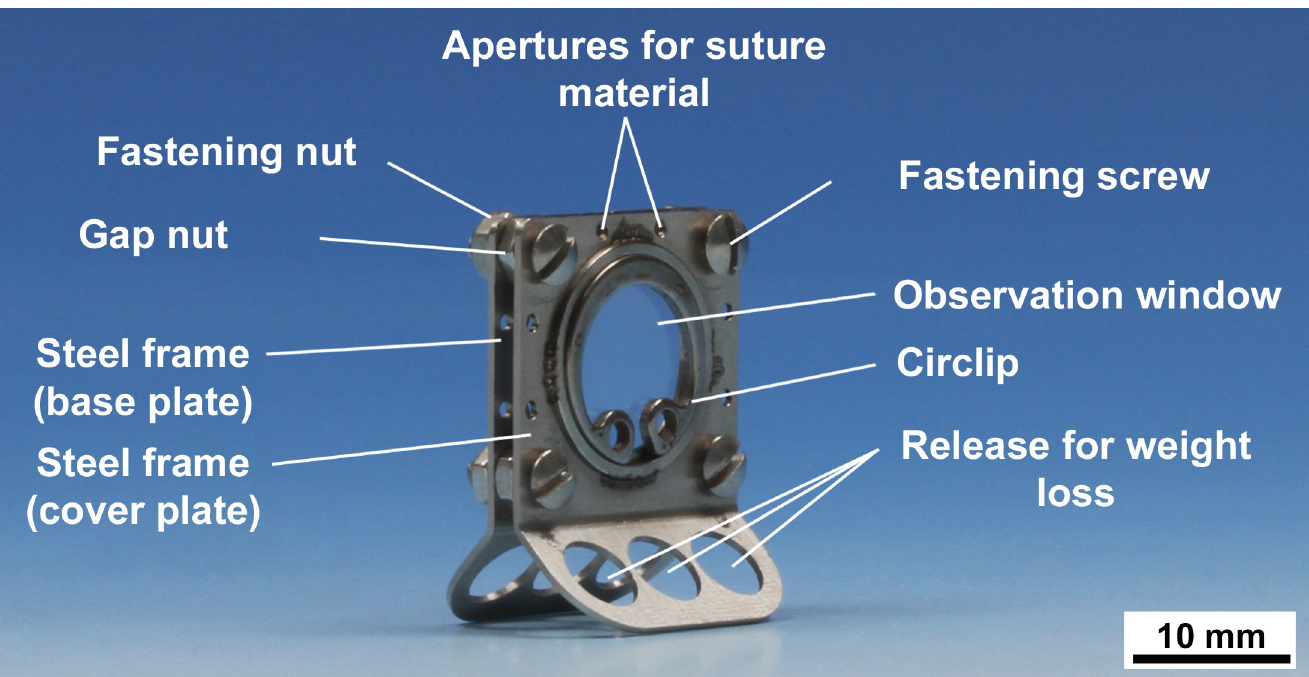
Fig 1. Dorsal skinfold chamber. Two symmetrical steel frames are connected via screws with a gap nut in between. The observation window ( Ø 12 mm) is covered with a coverslip, which is fixed by a circlip. Recesses reduce the weight of the chamber.